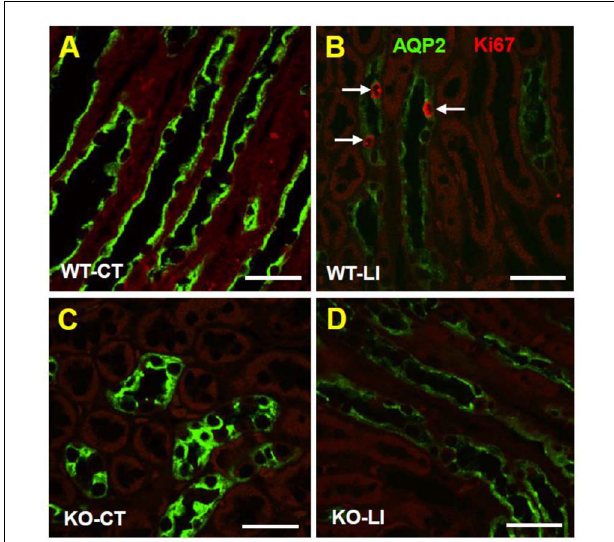
FIGURE 4 | Immunofluorescence imaging of cellular expression and disposition of AQP2 protein in the renal medulla of WT and KO mice fed control or lithium-added diets for 5 months. Representative images from the renal medulla are shown. Sections were co-stained for AQP2 (green) and the Ki67 (red), a nuclear cell marker for proliferation. Note the diminished AQP2 immunofluorescence in response to lithium-treatment in WT but not in KO mice, and the presence of Ki67 + cells in lithium-treated WT mice. WT-CT (A) , wild type mice on control diet; WT-LI (B) , wild type mice fed lithium-added diet; KO-C (C) , knockout mice on control diet; KO-LI (D) , knockout mice on lithium-added diet. Bar is 20 µ m.